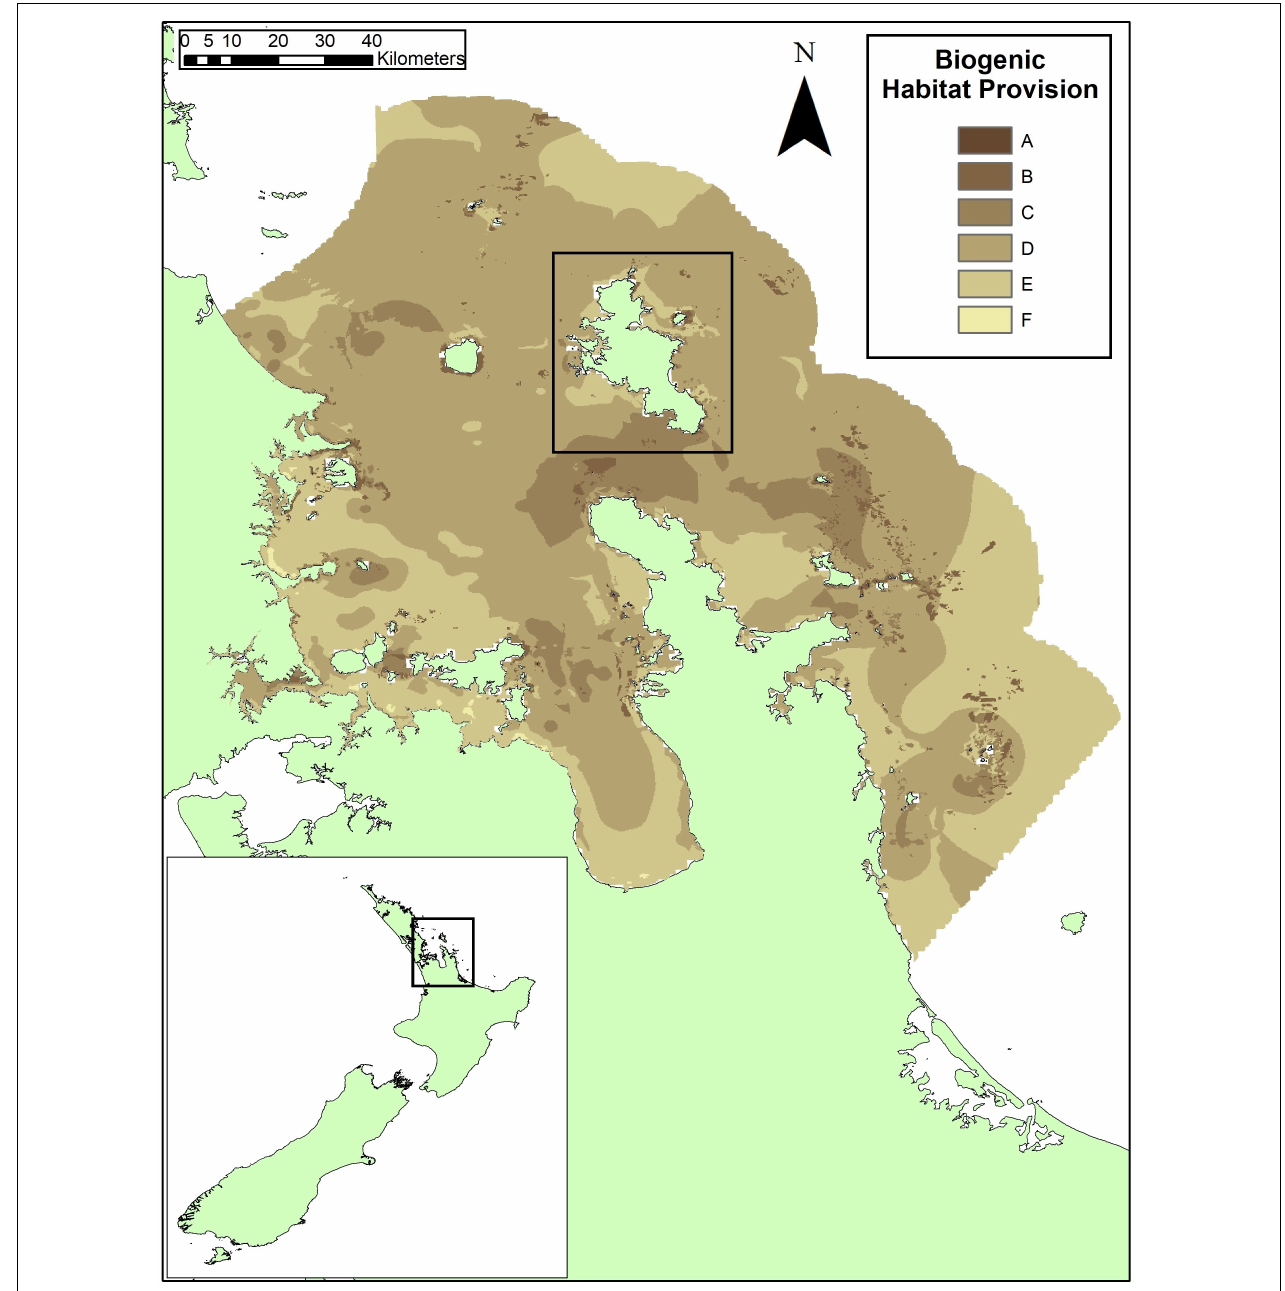
FIGURE 1 | The map of biogenic habitat provision service produced using the EP Approach for the Hauraki Gulf, New Zealand, from Townsend et al. (2014). Great Barrier Island is shown in the black box in the center of the figure. Model scores ranged from a 1.1 to 12.3 across the Hauraki Gulf and were converted to alphabetized classes for relative importance to service provision from high (A, darkest shading) to low (F, lightest shading). The class ranges in Townsend et al. (2014) were modified by combining the original Class A and B (A = model scores > 12; B = model scores 12–10) since these represented < 0.04% of the 34,000 cells. The range adjustment categorized class A as model scores > 10 and then divided classes evenly below: Class B, model scores 10–8; Class C, model scores 8–6; Class D, model scores 6–4; Class E, model scores 4–2; and Class F model scores below 2.